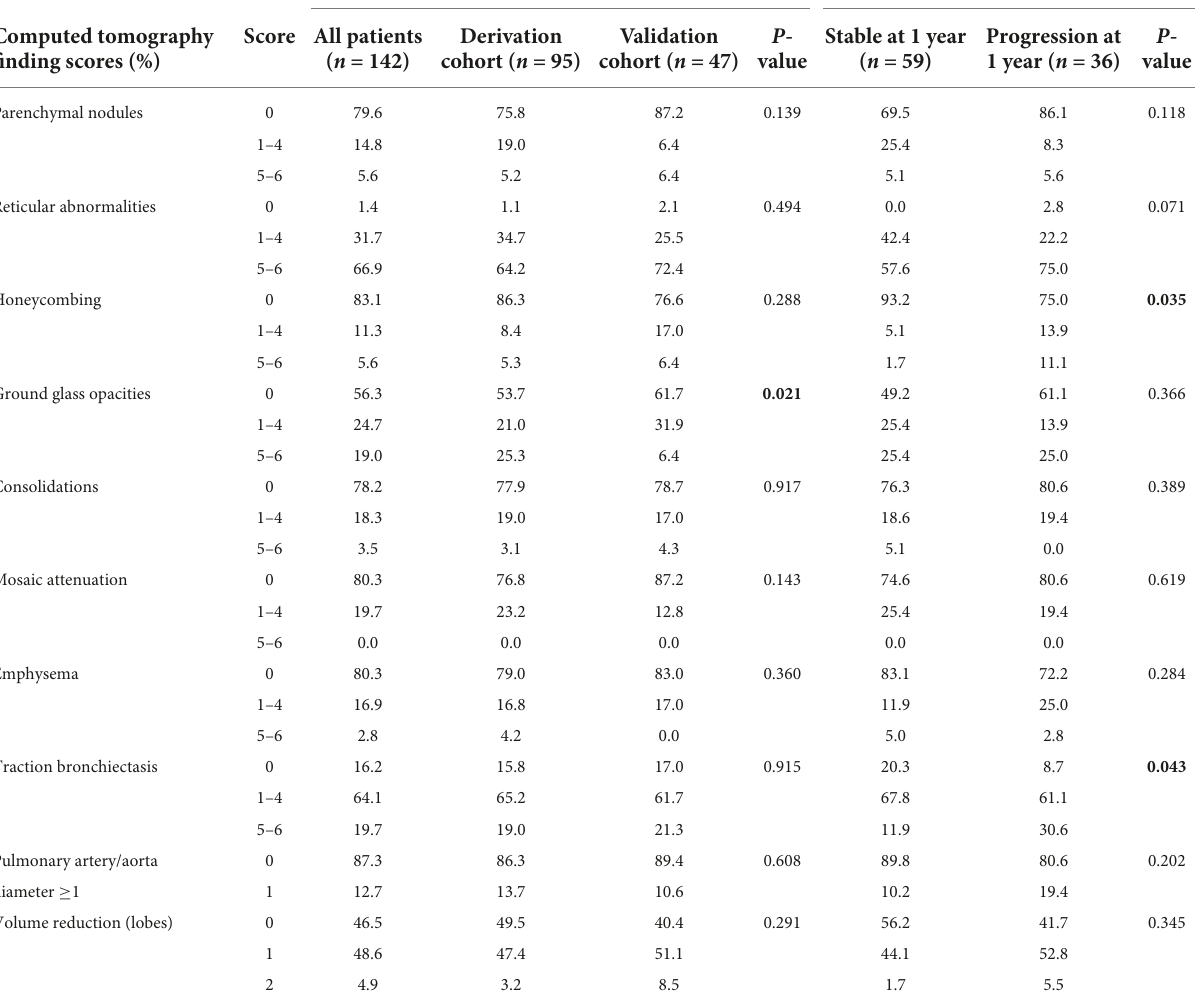
TABLE 3 Baseline computed tomography scores in all patients, the derivation, and the validation cohort as well as in the derivation cohort according to progression at 1 year. All patients ( n =